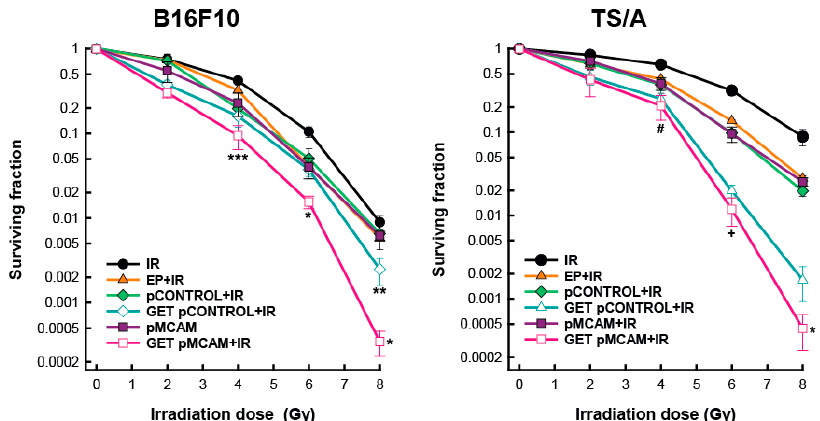
Figure 1. Survival of B16F10 melanoma and TS / A carcinoma cells after gene electrotransfer (GET) of plasmid DNA-encoding short hairpin RNA (shRNA) against melanoma cell adhesion molecule (pMCAM) and irradiation (IR). The data represent the mean and standard error of the mean ( n = 12). EP: application of electric pulses; pControl: control plasmid; * p < 0.05 compared to all other